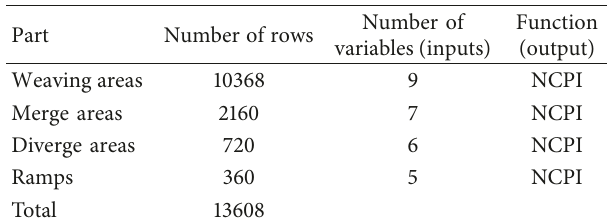
Table 4: The database